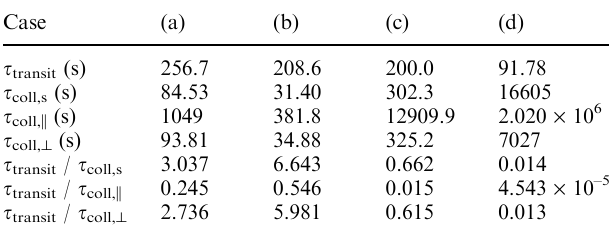
Table 6. H + time scales at 5000 km